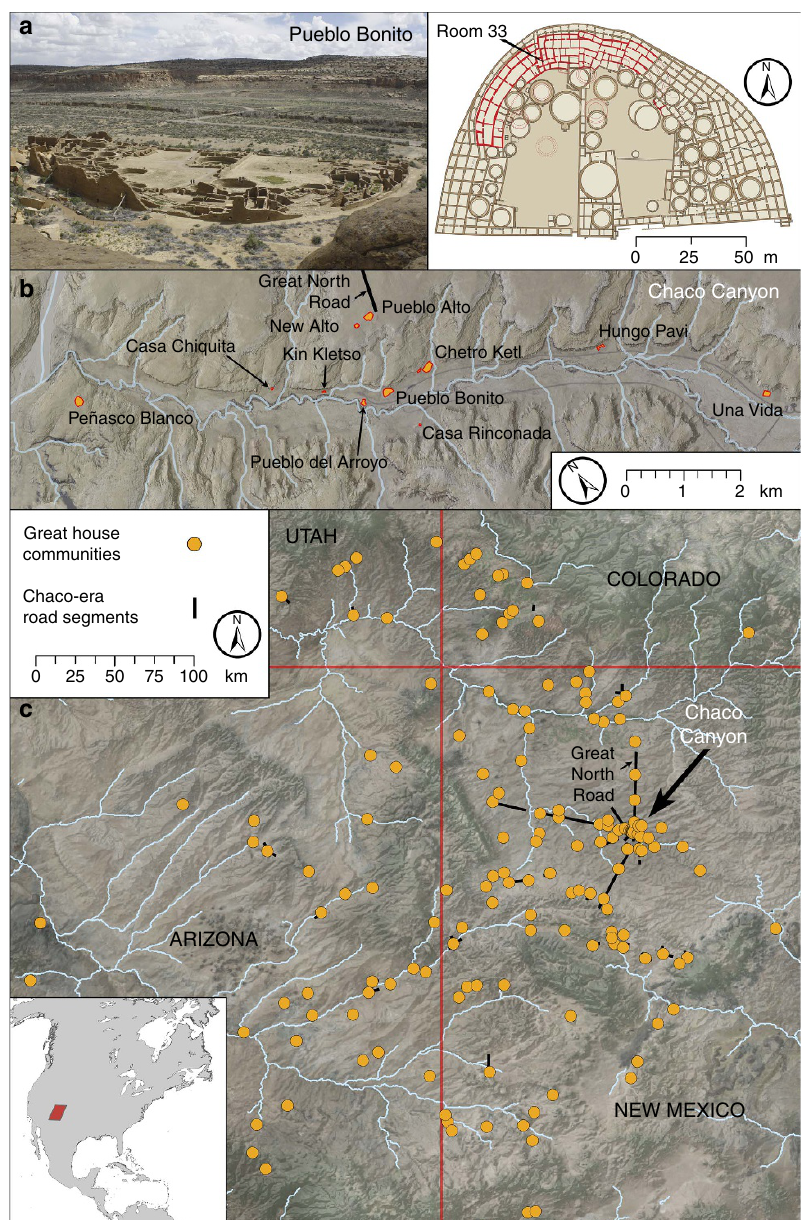
Figure 1 | Photographs and maps of Pueblo Bonito and surrounding Chacoan sites. ( a ) Photograph and plan view map of Pueblo Bonito with the location of room 33 noted (photo: G. Perry). ( b ) Locations of the primary great houses in Chaco Canyon. ( c ) Locations of settlements of Chaco Canyon with great house-style architecture with inset showing North America. Maps and graphical layout: T. Harper. Each major element (other than the photograph, labels and legends) was produced in ArcGIS 10.4. All subsequent layout and design were performed in Photoshop CC